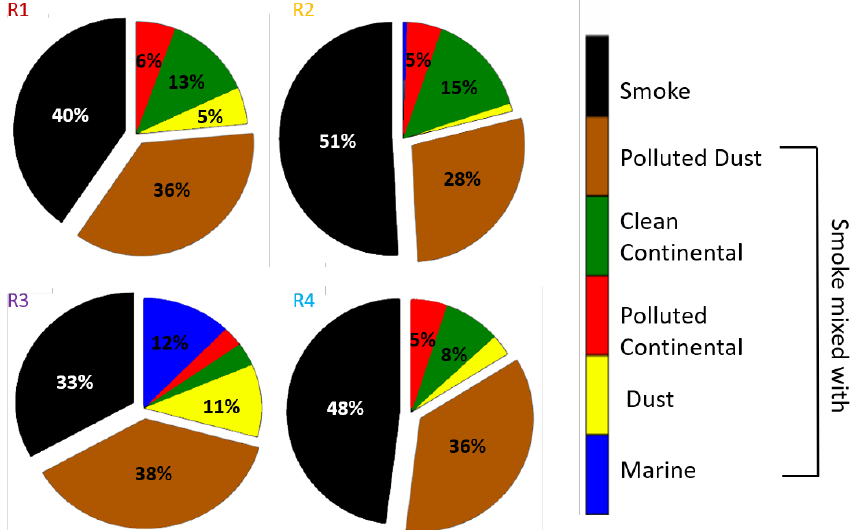
Figure 7. Percentages of the aerosol layers mixing types for the subregions ( R1 – R4 ). Aerosol types found in percentages less than 3%, are not presented with numbers in the figure.